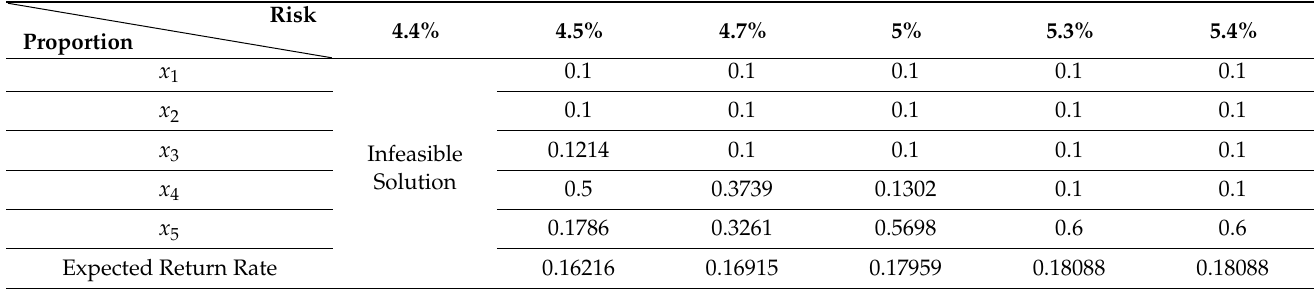
Table 7. The efficient portfolio with s = 3 in a guaranteed return rate (cid:101) p 1 .